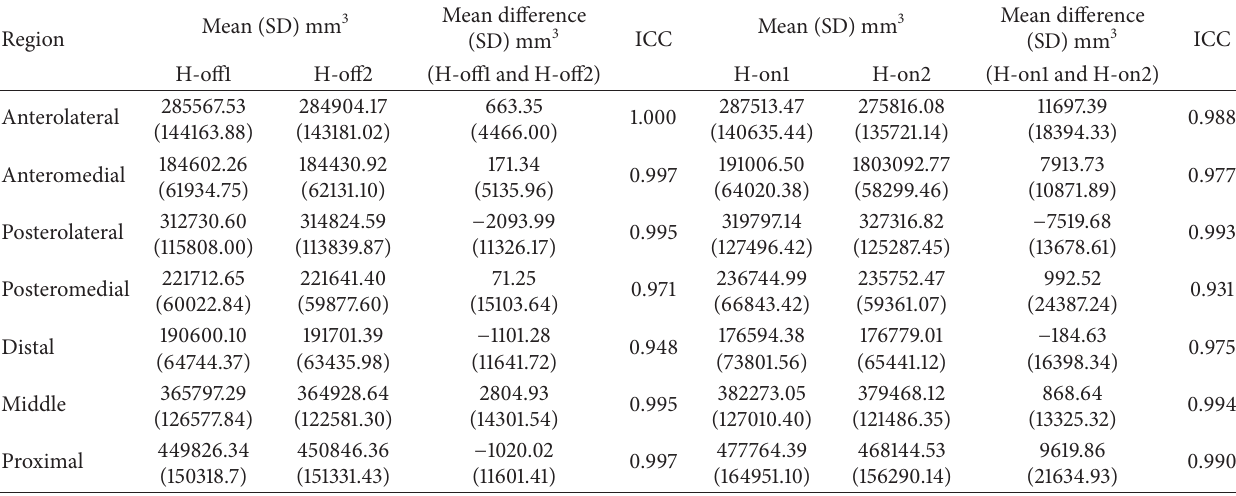
Table 4: The regional mean and standard deviation of volume (mm 3 ) for each repetition (Rep 1 and Rep 2) of casting concepts, the ICC, and intra cast volume difference.